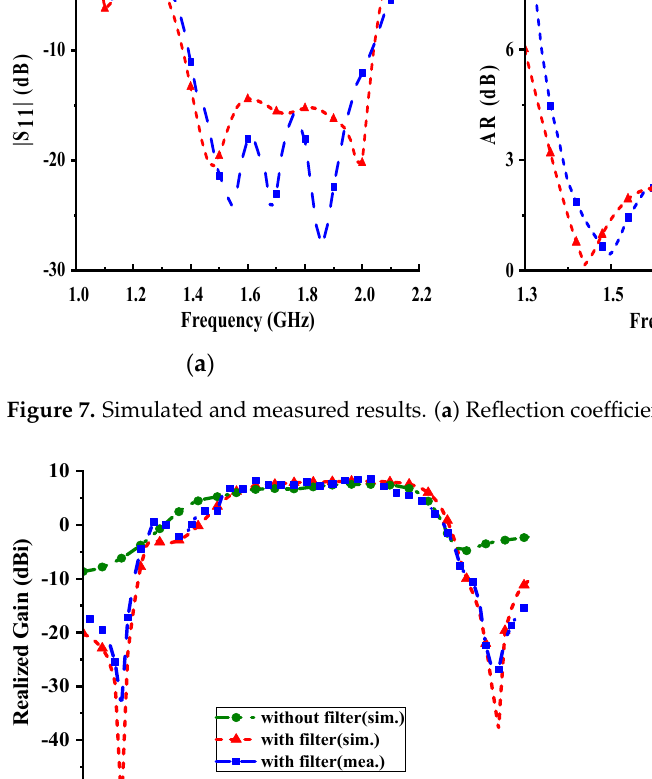
without filter(sim.) with filter(sim.) with filter(mea.)